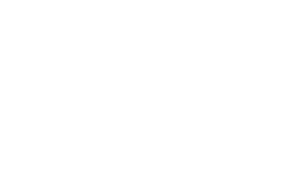
Figure 4. Sample of cubes configurations in ( a ) without complexity and ( b ) with complexity.